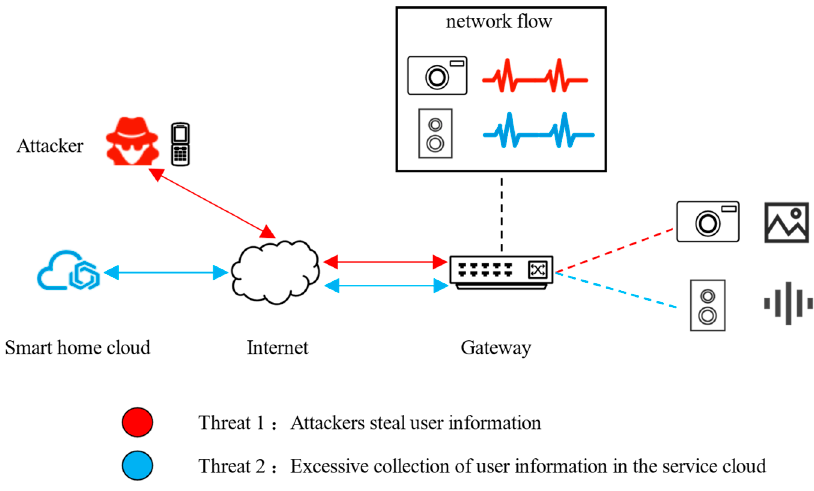
Figure 1. Smart home privacy